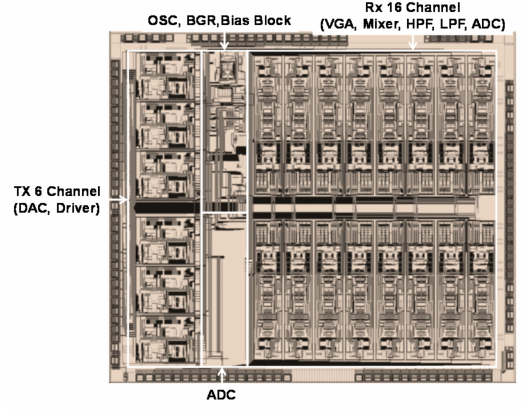
Figure 21. Chip microphotograph.